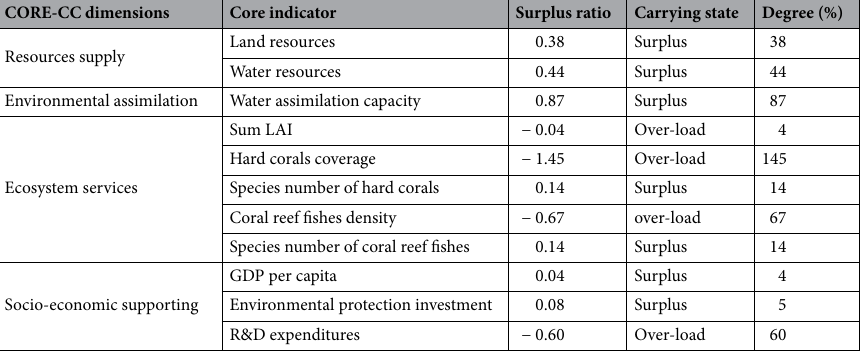
Table 4. Assessment of core indicator of CORE-CC in ZSI in